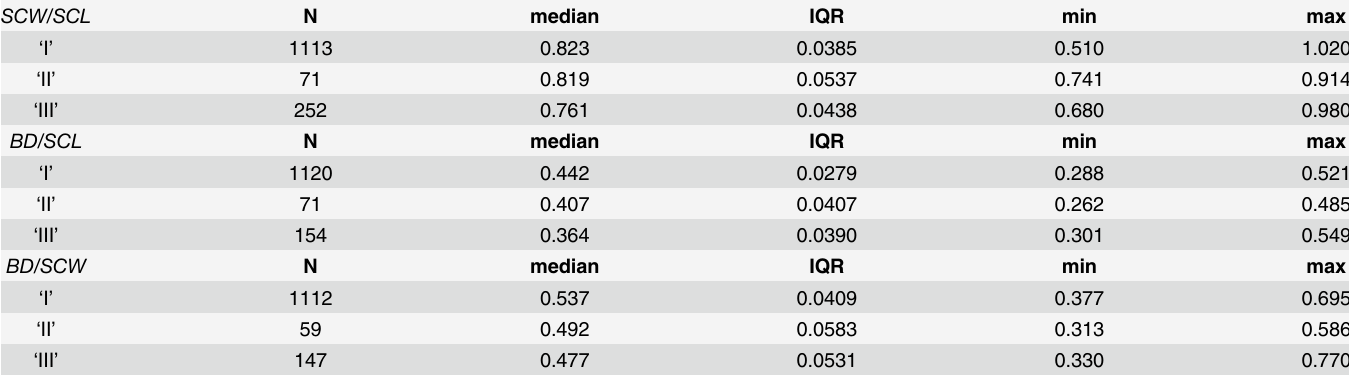
Table 4. Descriptive statistics. Number of data points ( N ), median, interquartile range (IQR), minimum, and maximum of ratios, for life stage subsets ‘ I ’ , ‘ II ’ , and ‘ III ’